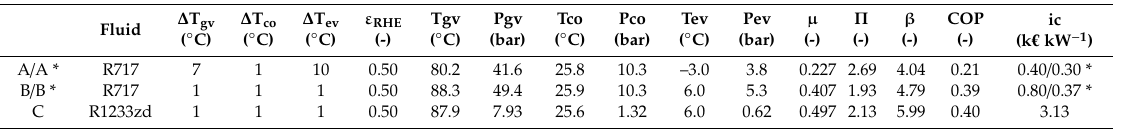
Table 6. Summary of the three configurations chosen as possible optimum case. The asterisk solutions refer to the use of a plate heat exchanger instead of a shell and tube heat exchanger for the low-pressure evaporator.